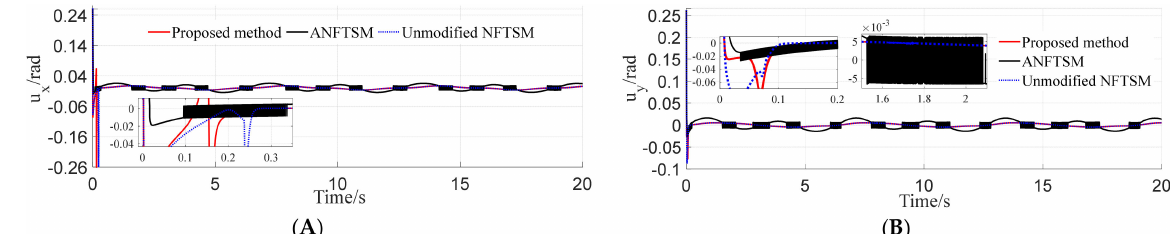
Figure 8. Position tracking errors. ( A ) X-direction, ( B ) Y-direction.